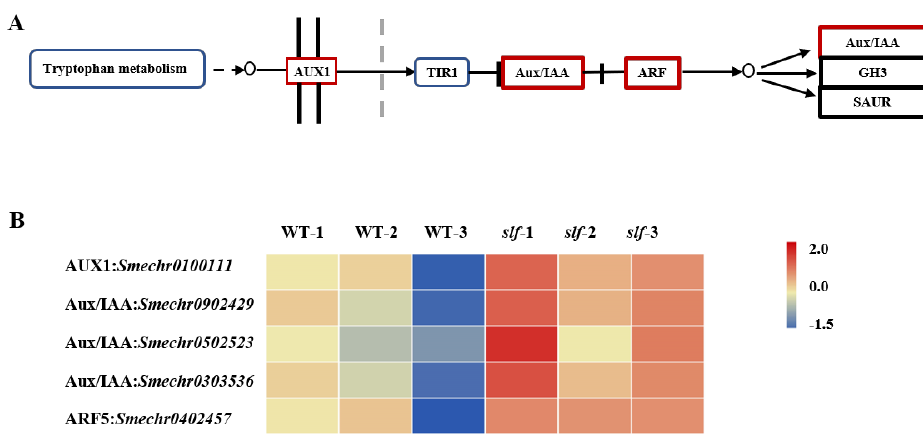
Figure 5. Differentially expressed genes (DEGs) in the auxin signaling pathway. ( A ) Auxin signaling pathway regulates the expression of auxin-responsive genes through the F-box protein TIR1 and cooperative action of Aux/IAA transcriptional repressors and ARFs. Red rectangles represent genes that were significantly upregulated in slf vs. WT ( B ) Expression levels of DEGs in the auxin signaling pathway in the WT and slf samples. Values are the mean ± SE of three biological replicates. To validate the RNA-seq data, the expression levels of DEGs were measured using quantitative real-time PCR (qRT-PCR). A total of eight genes related to auxin signaling and the pathogen interaction pathway were selected (Figure 6A and Supplementary Ma- teraials Table S1). The overall correlation coefficient of a linear regression analysis was 0.8796 (Figure 6B).